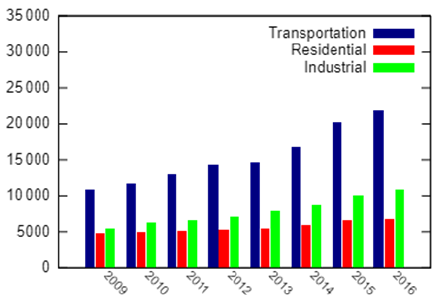
Figure 6. Annual CO 2 emissions (unit: Gg) of three key sectors: transportation, manufacturing industry and residential in